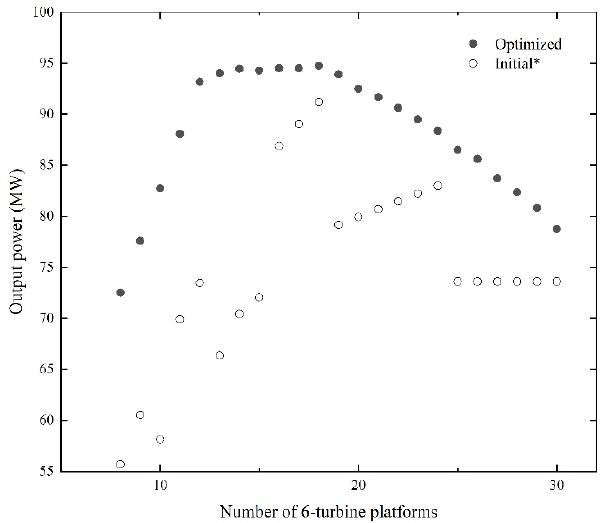
Figure 4. Output powers of optimized and initial layouts. * Power productions of the initial layouts from 8 to 15 platforms are the power after one iteration step.